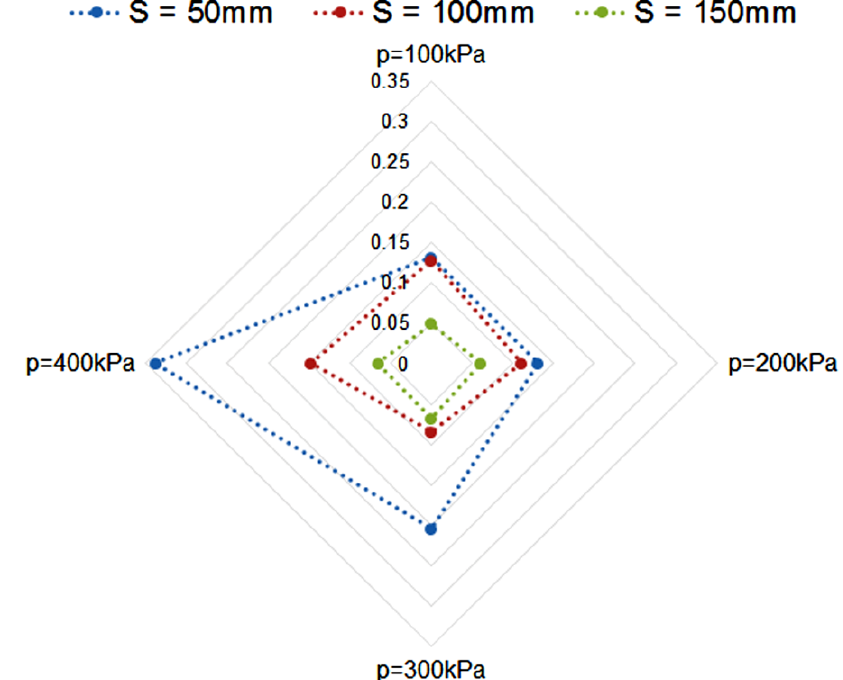
Figure 7. The ratio of retention (%) of the chemical agent on the seed potato surface for the electronically controlled valve, depending on the falling path distance (mm) (air pressure reduced by 50 kPa).